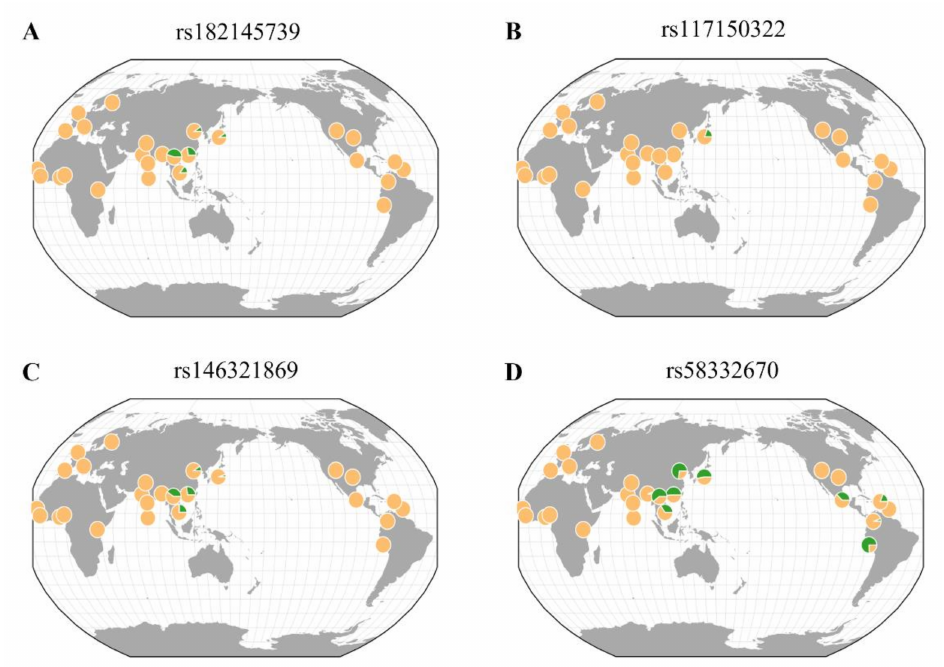
Figure 3. Geographical distributions of rare variants associated with eGFR and CKD. Each pie chart shows a minor allele frequency based on 1000 genomes (hg 19). The frequency scale of the green pie is the proportion out of 0.1. ( A ) rs182145739, ( B ) rs117150322, ( C ) rs146321869, ( D )